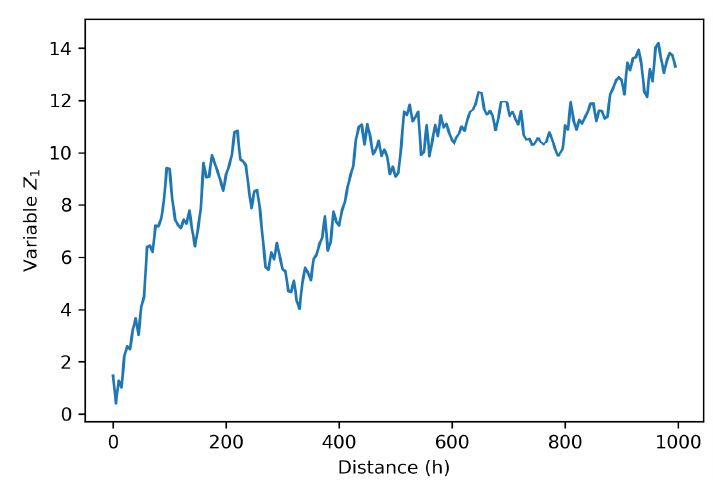
Figure 4. Local stationarity behavior of Z 1